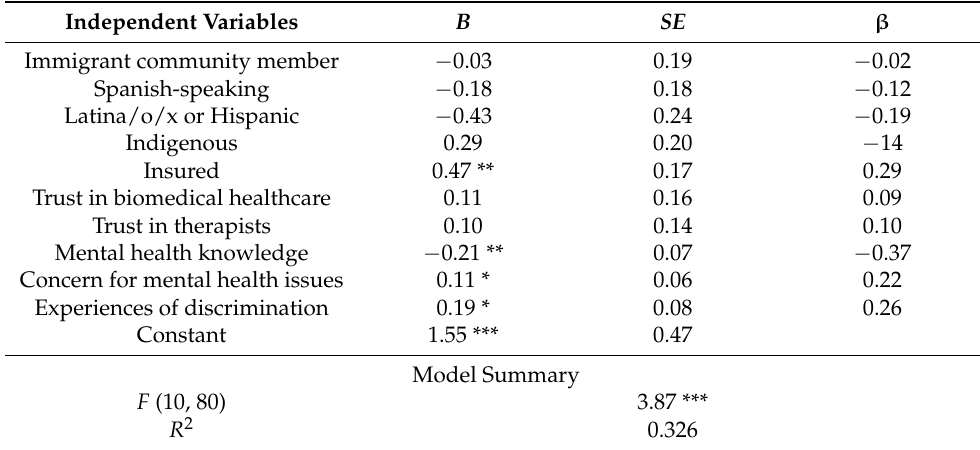
Table 3. Factors Associated with General Anxiety Disorder Symptoms among Latinx Immigrant